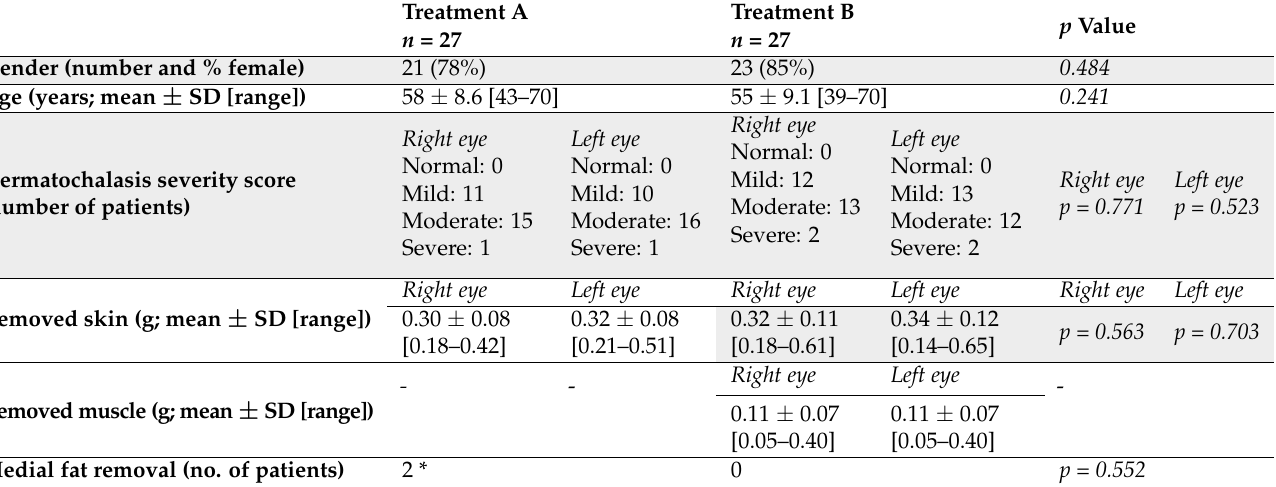
Table 1. Patient characteristics after